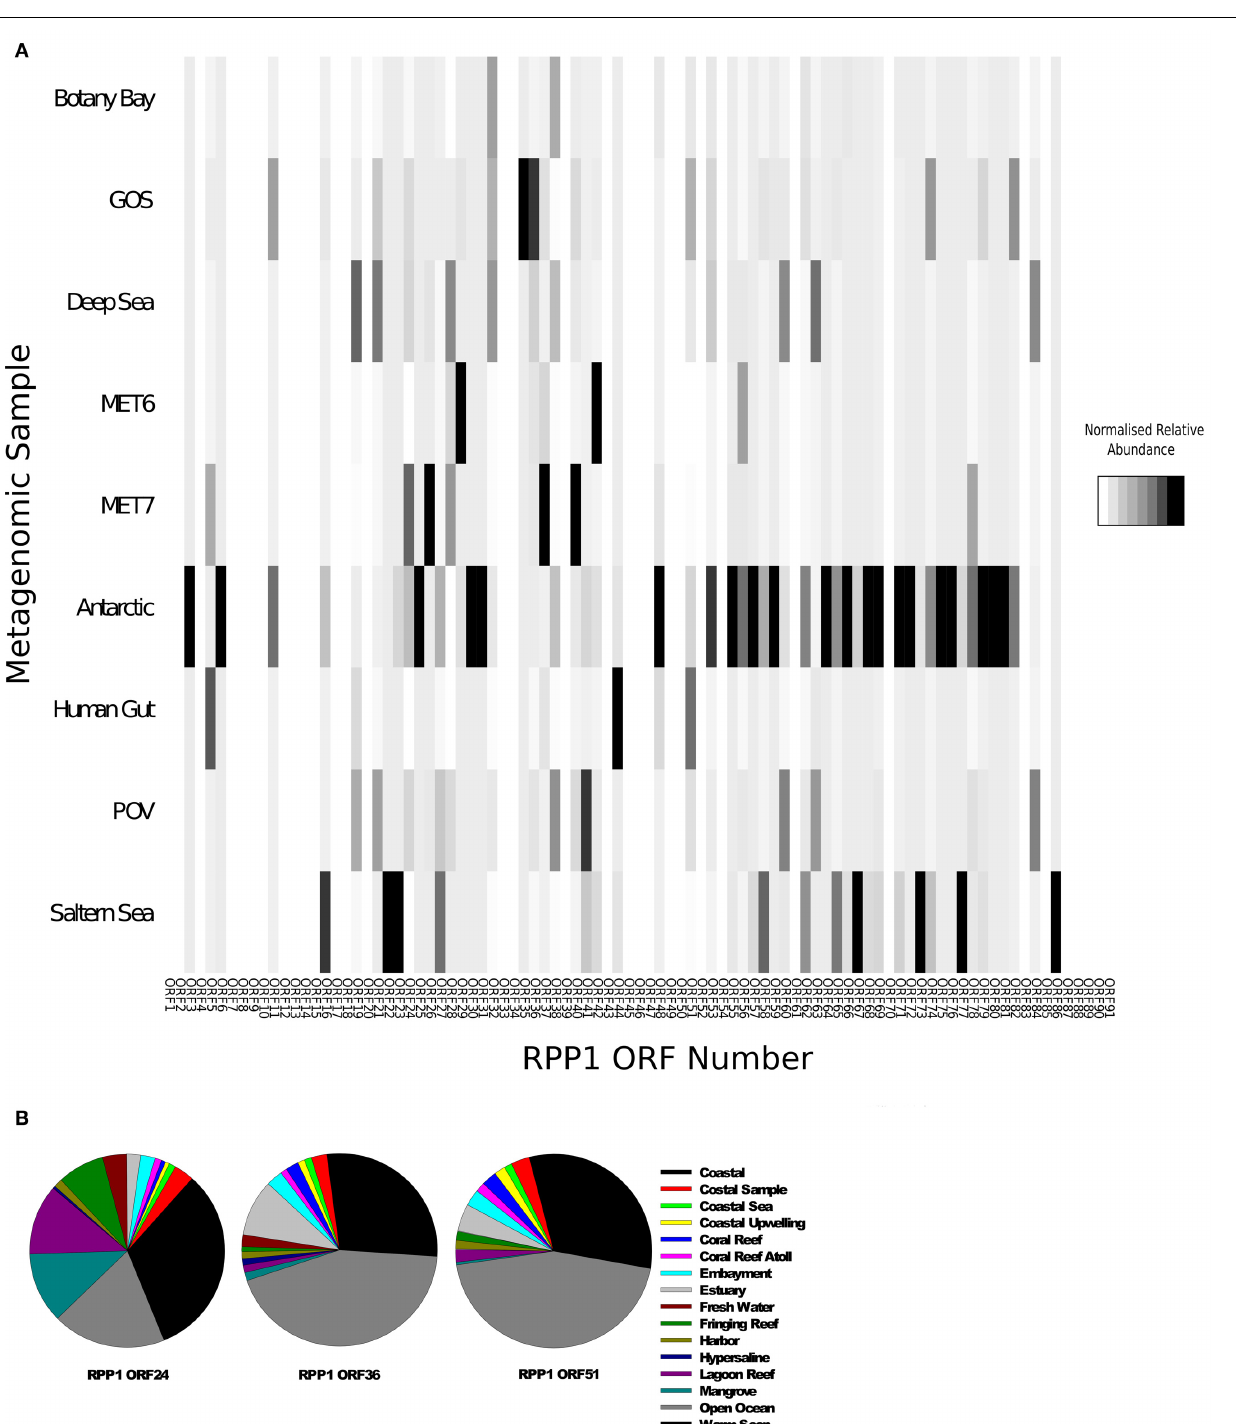
FIGURE 6 | Relative abundance of RN4-like phage genes in various metagenomes. (A) Heatmap of the normalized relative abundance of RPP1 ORFs identified in the Global Ocean Survey (GOS), Botany Bay, Deep sea, Lake Pavin (MET7), Lake Bourget (MET6), Antarctic, human